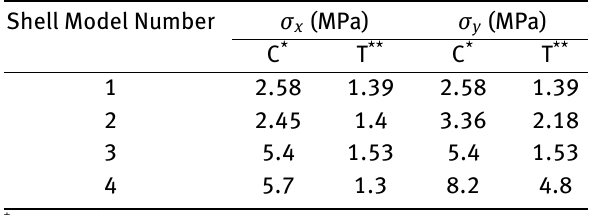
Table 6: Stresses at the center of four funicular shell models under a central concentrated load of 30 kN Shell Model